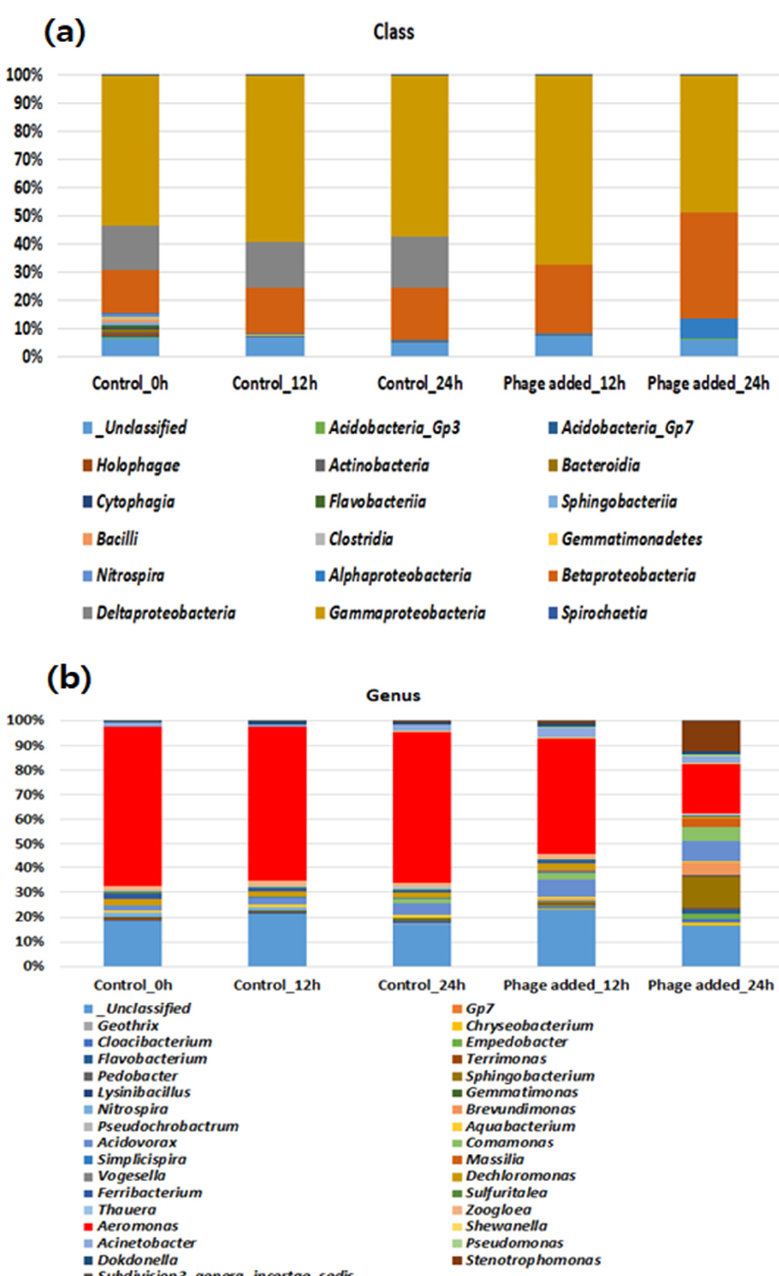
Figure 6. Microbial analysis by employing next generation sequencing before and after aerophage treatment (( a ) Class level and ( b ) Genus level).